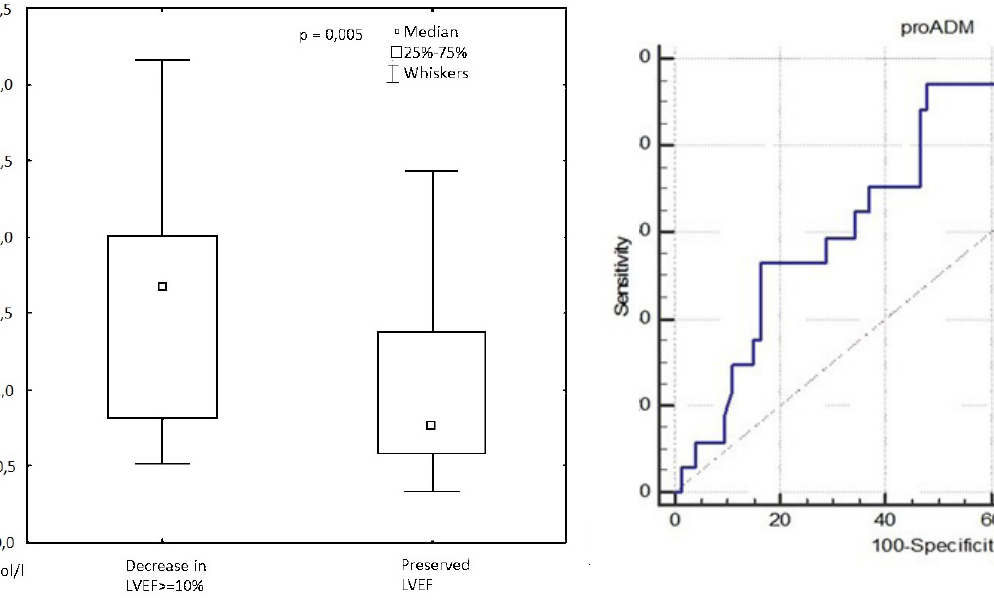
Fig. 3 - Receiver operating characteristic curve for a decrease in ejection fraction. AUC=area under the curve; proADM=proadrenomedullin.